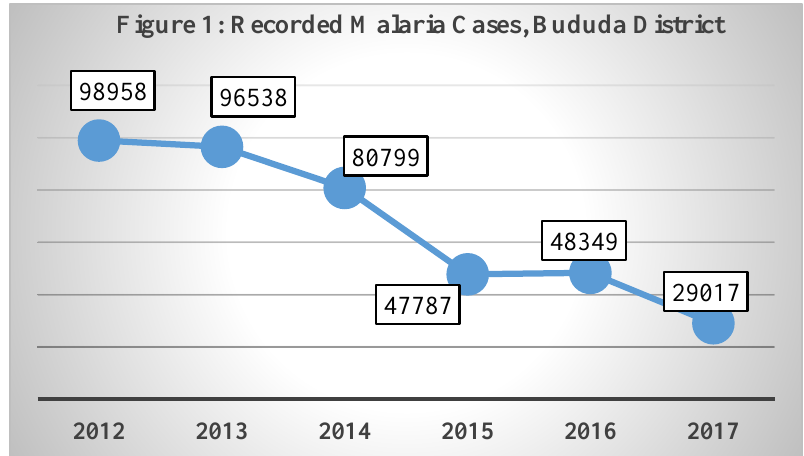
Figure 1: Recorded Malaria Cases, Bududa